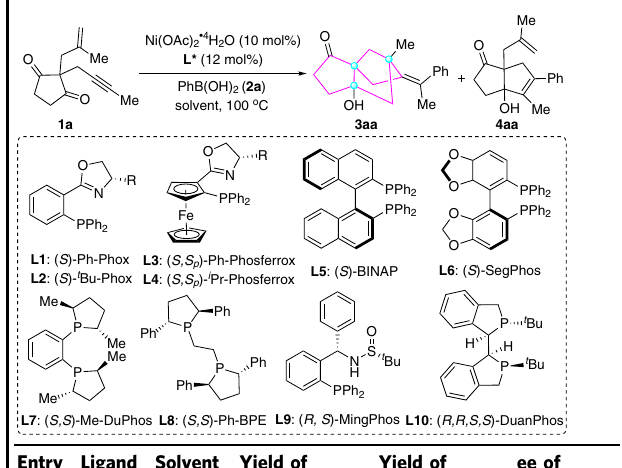
Table 1 Optimization of reaction conditions a .